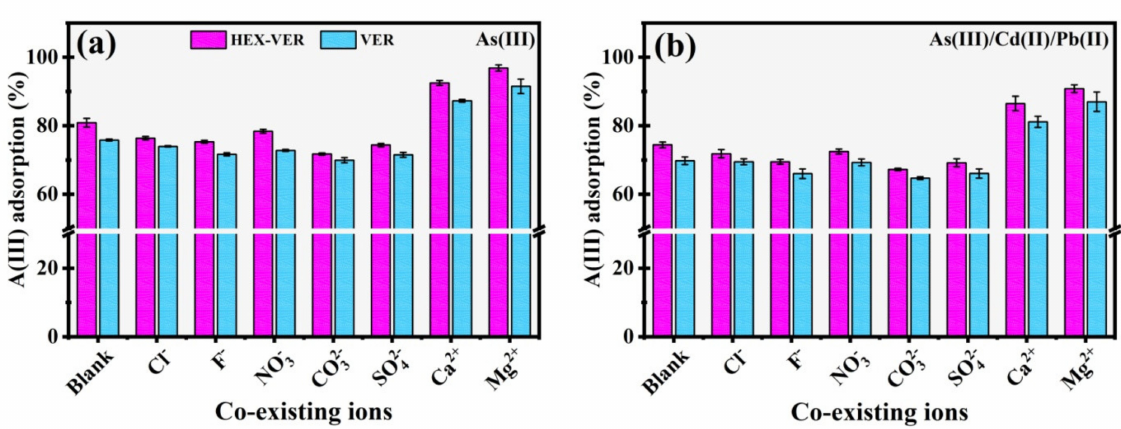
Figure 6. The effect of co-existing ions on adsorption of As(III) singular ( a ), and in the presence of Cd(II)/Pb(II) ( b ) on VER and HEX–VER; adsorbent dosage: 1.0 g · L − 1 ; contact time: 1440 min; temperature: 30 ◦ C; ionic strength 5 mg.L − 1